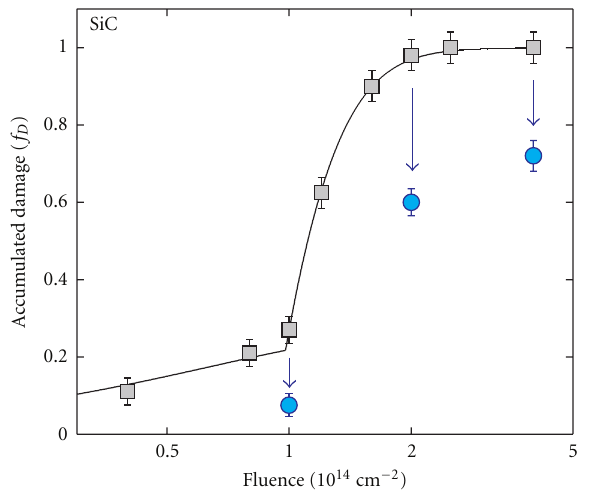
Figure 12: Accumulated damage ( f D ) versus ion fluence for silicon carbide crystals irradiated at RT with 100keV Fe ions (squares), and subsequently irradiated at RT (at 2 × 10 13 cm − 2 ) with 870 MeV Pb ions (circles). The solid line is a fit to Fe irradiation data using the MSDA model [23,